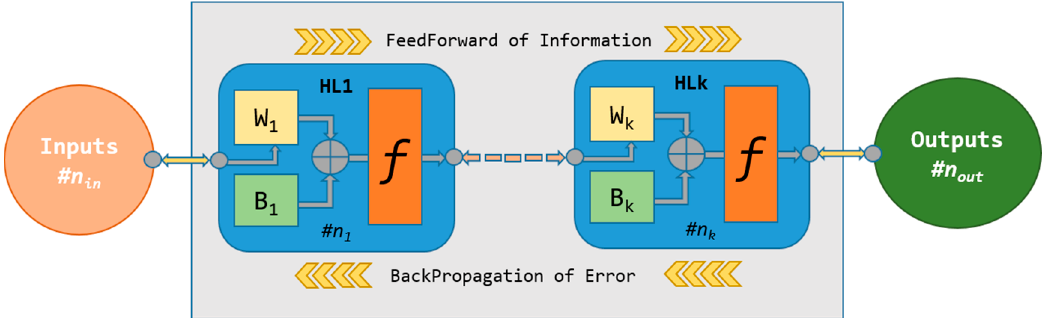
Figure 1. Feedforward-backpropagation ANN structure: in each HL a number #n k of artificial neurons are connected and correlated through the weight matrix (W k ) and the bias matrix (B k